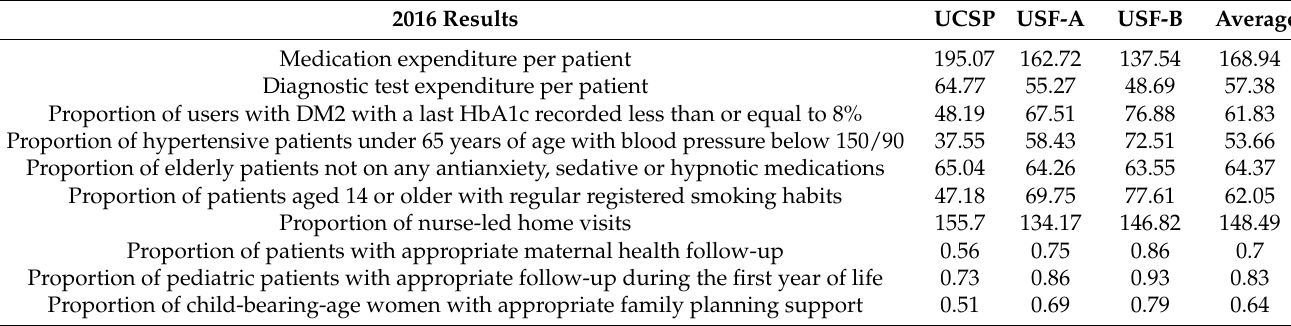
Table 4. Indicator results (2016) by PHC unit